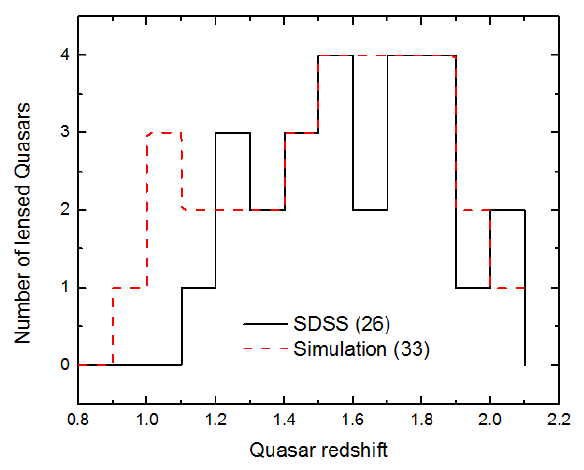
Figure 1. Histogram of the redshift distributions for 26 lensed Quasars observed by the SDSS (continuous line) and for 33 synthetic lensed Quasars (dashed